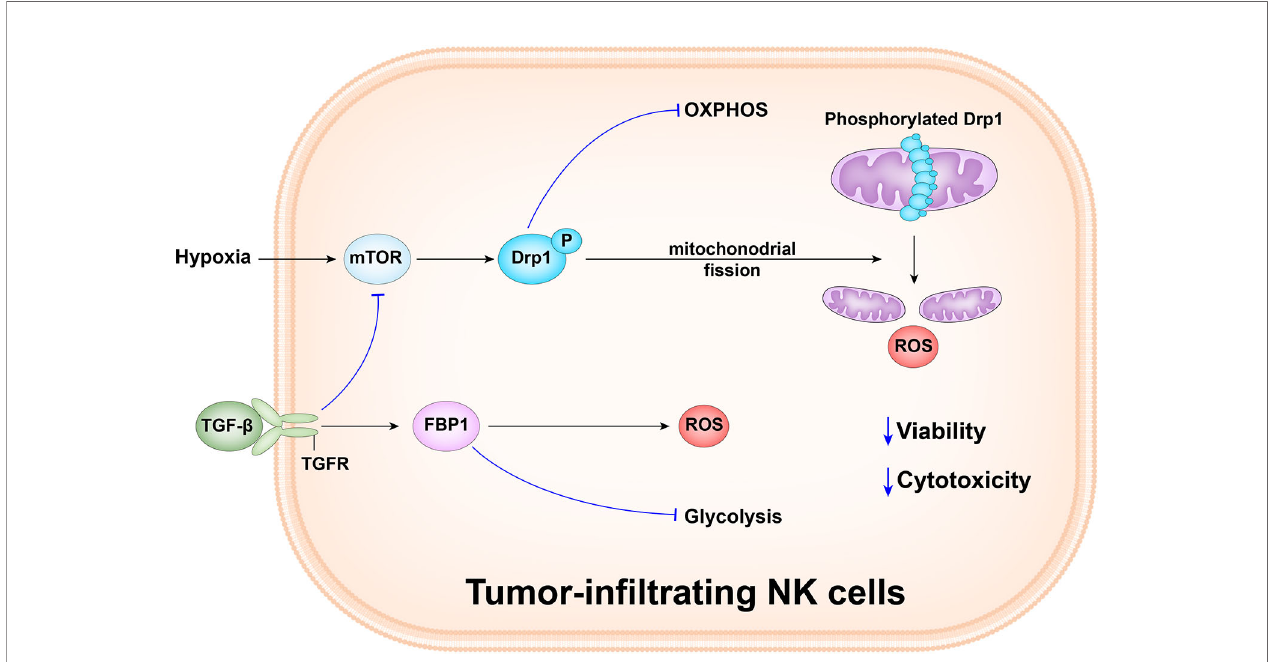
FIGURE 2 | Tumor-in fi ltrating NKcells in human liver cancer have small, fragmented mitochondria in their cytoplasm,while tumorand peripheral NK cellsinthe liver have normallarge, tubular mitochondria. Mitochondrial fragmentation causes tumor to evadeNK cell-mediated surveillance. The hypoxictumor microenvironment promotes the continuousactivation of the mechanism target of rapamycin-GTPase motor associated protein 1(mTOR-DRP1)in NK cells, leadingto excessive mitochondrial fragmentation andenhance the viability andanti-tumor ability of NK cells. Besides, the abnormally expressed gluconeogenic enzyme, FBP1, inresponse to TGF b , can inhibitNKcell glycolysisand promotes the production ofreactive oxygen species (ROS),and causes dysfunction by inhibiting glycolysisand reducing